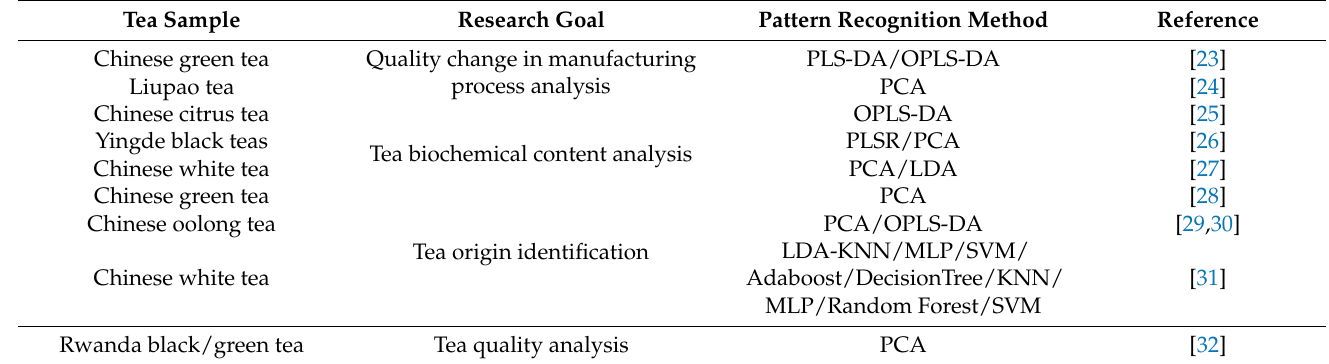
Table 1. The main results from studies using GC-IMS to analyze tea that have been published since 2020. Tea